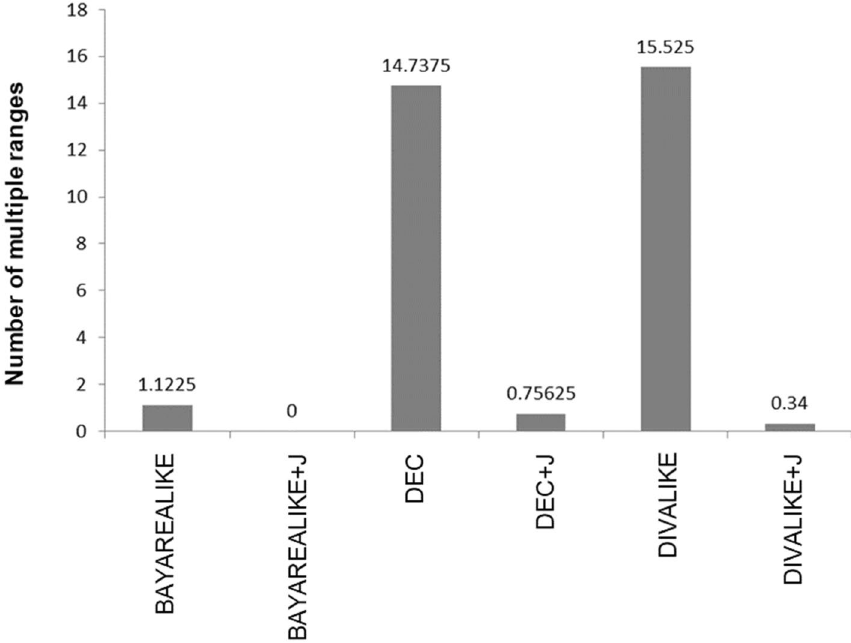
Figure 3. The average number of multiple ranges suggested at ancestral nodes differed among the two and three free parameter biogeographic